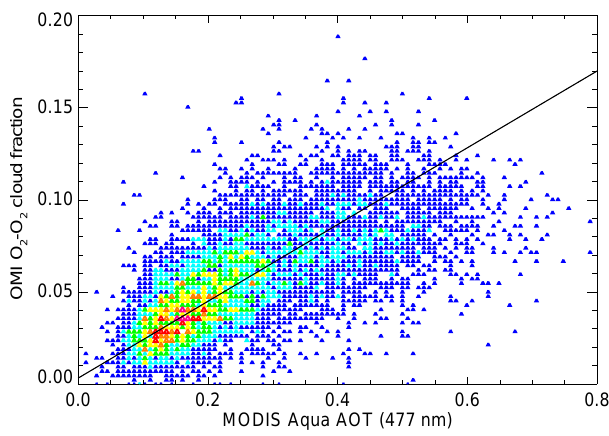
Fig. 12. Scatterplot for MODIS Aqua AOT at 470 nm (x-axis) and coinciding OMI O 2 -O 2 effective cloud fractions (y-axis) observed in July 2005 (13:30 hrs local time). The colours indicate the number of times a particular grid cell has been filled, where dark blue corresponds to 1 time and red to more than 6 times. OMI effective cloud fractions can be expressed as 0.21 × AOT (reduced major axis regression). Cloud fractions have been selected only for those days and locations that had a successful, cloud-free, MODIS AOT retrieval 15 minutes prior to OMI.